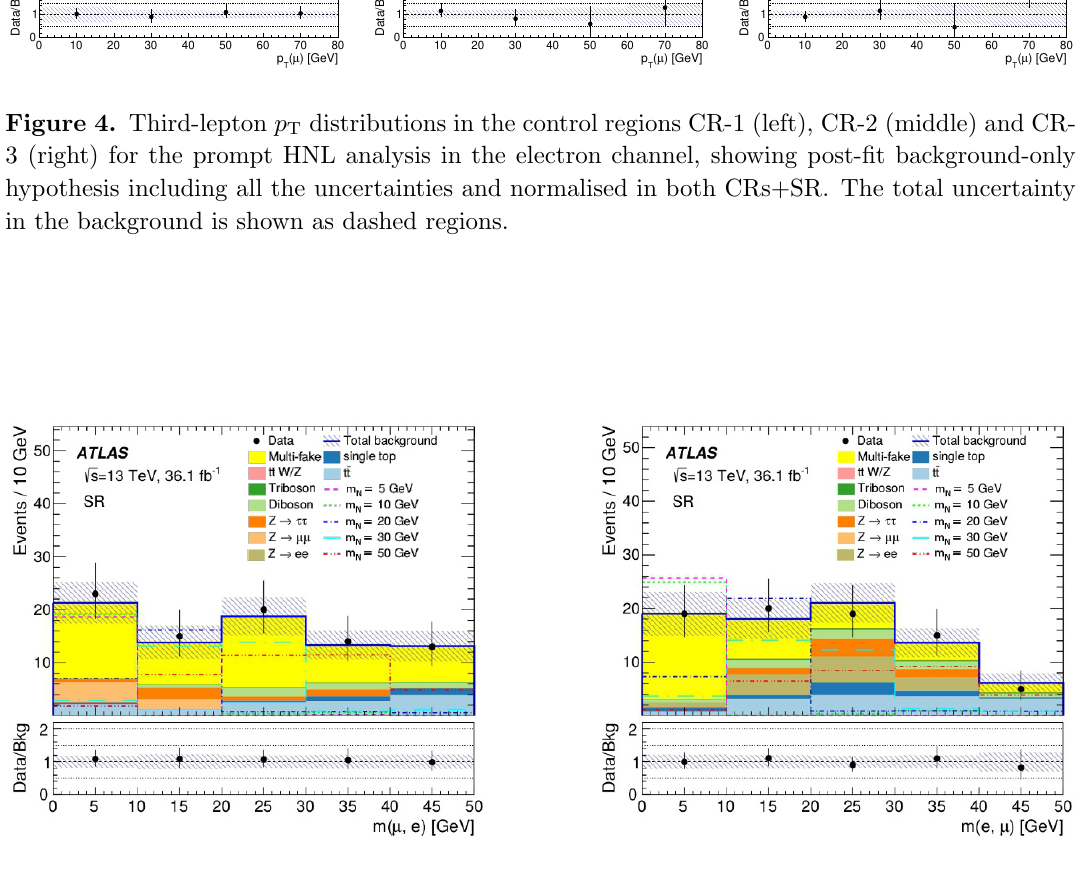
Figure 5. Data-to-prediction comparison of dilepton invariant mass distributions in the signal regions for the prompt signature in the muon (left) and electron (right) channels. The prediction including its uncertainty is post-(cid:12)t. The total uncertainty in the background is shown as dashed regions. Signal yields, overlaid as lines, correspond to observed 95% con(cid:12)dence-level exclusion limits for di(cid:11)erent mass scenarios: for the muon channel, the signals have ( m N , c(cid:28) , j U j 2 ) values of (5 GeV, 4.5 mm, 7.1 (cid:2) 10 (cid:0) 5 ), (10 GeV, 2.7 (cid:2) 10 (cid:0) 1 mm, 3.2 (cid:2) 10 (cid:0) 5 ), (20 GeV, 2.1 (cid:2) 10 (cid:0) 2 mm, 1.1 (cid:2) 10 (cid:0) 5 ), (30 GeV, 2.2 (cid:2) 10 (cid:0) 3 mm, 1.3 (cid:2) 10 (cid:0) 5 ) and (50 GeV, 8.2 (cid:2) 10 (cid:0) 5 mm, 2.5 (cid:2) 10 (cid:0) 5 ); for the electron channel, the signals have ( m N , c(cid:28) , j U j 2 ) values of (5 GeV, 1.6 mm, 1.9 (cid:2) 10 (cid:0) 4 ), (10 GeV, 2.1 (cid:2) 10 (cid:0) 1 mm, 4.1 (cid:2) 10 (cid:0) 5 ), (20 GeV, 1.6 (cid:2) 10 (cid:0) 2 mm, 1.4 (cid:2) 10 (cid:0) 5 ), (30 GeV, 1.9 (cid:2) 10 (cid:0) 3 mm, 1.5 (cid:2) 10 (cid:0) 5 ) and (50 GeV, 5.4 (cid:2) 10 (cid:0) 5 mm, 3.8 (cid:2) 10 (cid:0) 5